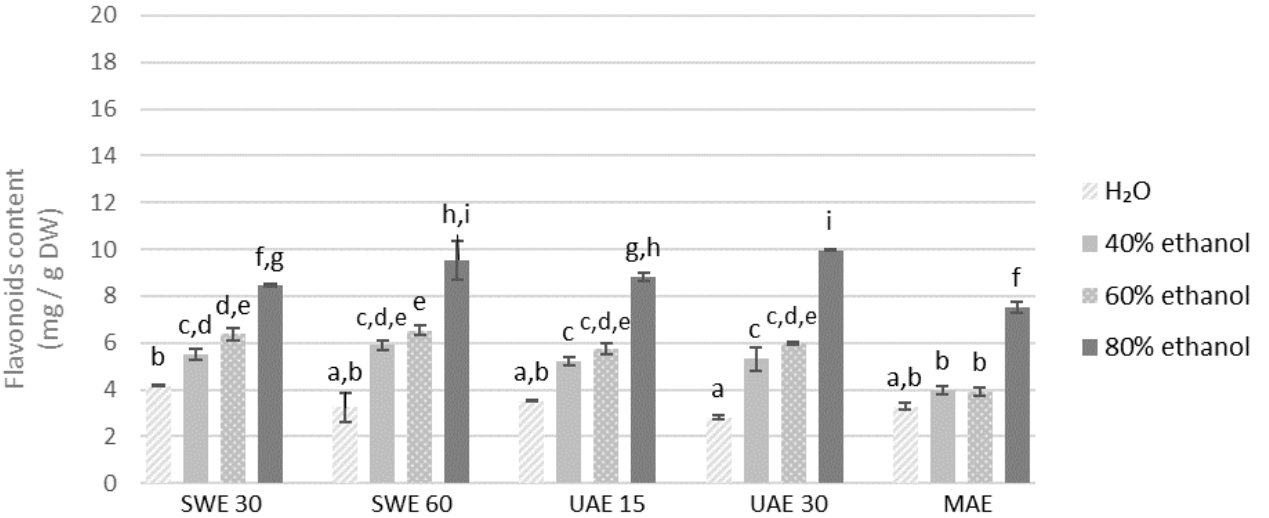
Figure 4. Flavonoids content in the extracts obtained from the fraction with particle size 0.5–1.25 mm. SWE—shaking water bath extraction; UAE—ultrasound-assisted extraction; MAE—microwave assisted extraction; 15, 30 or 60-time of extraction. Results are presented as the mean ± SD from triplicate determinations. Different letters: a, b, c, d, e, f, g, h, i indicate that samples are significantly different. The letter “a” marks the lowest value. Higher values are marked with consecutive letters of the alphabet. Bars that share the same letter within the group are not significantly different according to Tukey’s HSD test at p > 0.05.